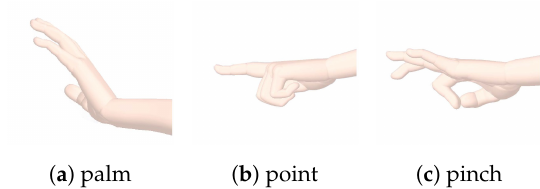
Figure 1. Target gestures the system will assist the user in creating.